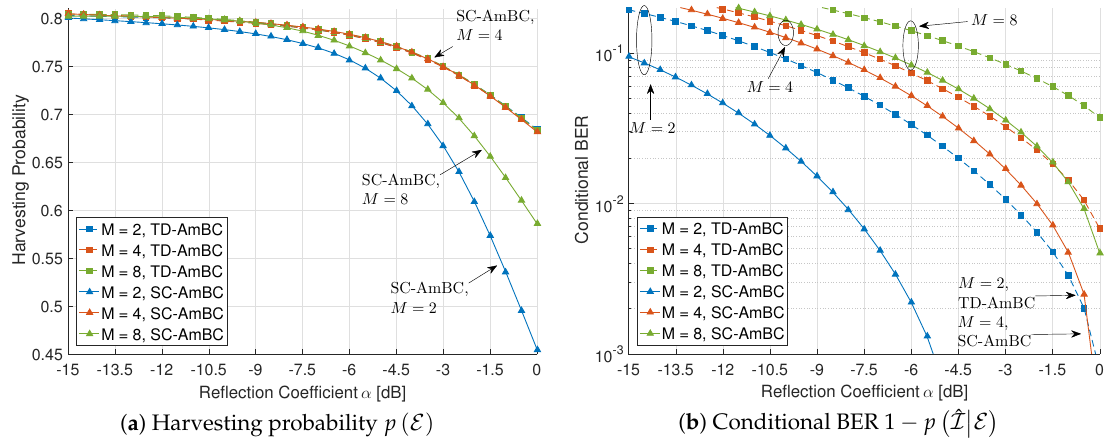
Figure 8. Effect of the modulation order M ( L + = 3, K = 4, λ = 1.5 for